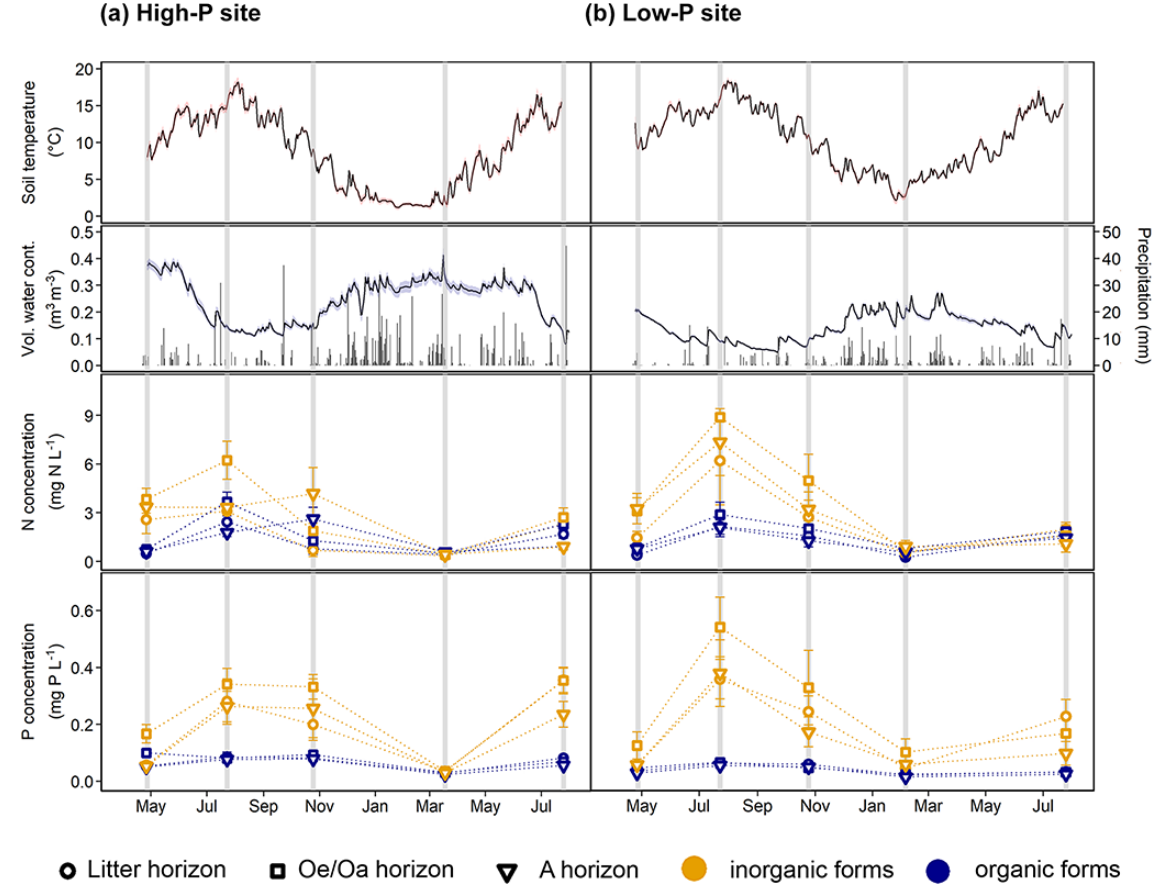
Figure 1. Soil temperature, soil moisture, and concentration of inorganic and organic nitrogen (N) and phosphorus (P) form during the experimental duration at the high-P site (a) and the low-P site (b) . Row 1 and 2: soil temperature and volumetric water content measured at 5cm in the A horizon during the sampling period. Row 3 and 4: organic and inorganic N and P concentrations in leachates from litter, the Oe / Oa horizon, and A horizon for each site and horizon (including fertilization treatments, n = 12), at five samplings at the two sites. Error bars are standard error. Data for dissolved organic carbon can be found in Sect.